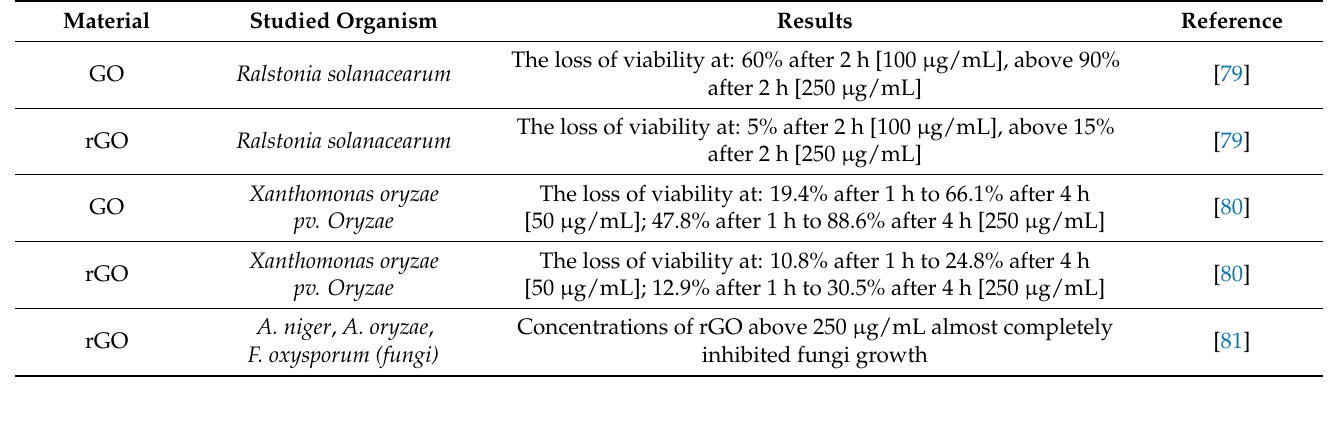
Figure 3. Publications per year on “graphene” in the field of biomaterials. Data retrieved from Web of Science.